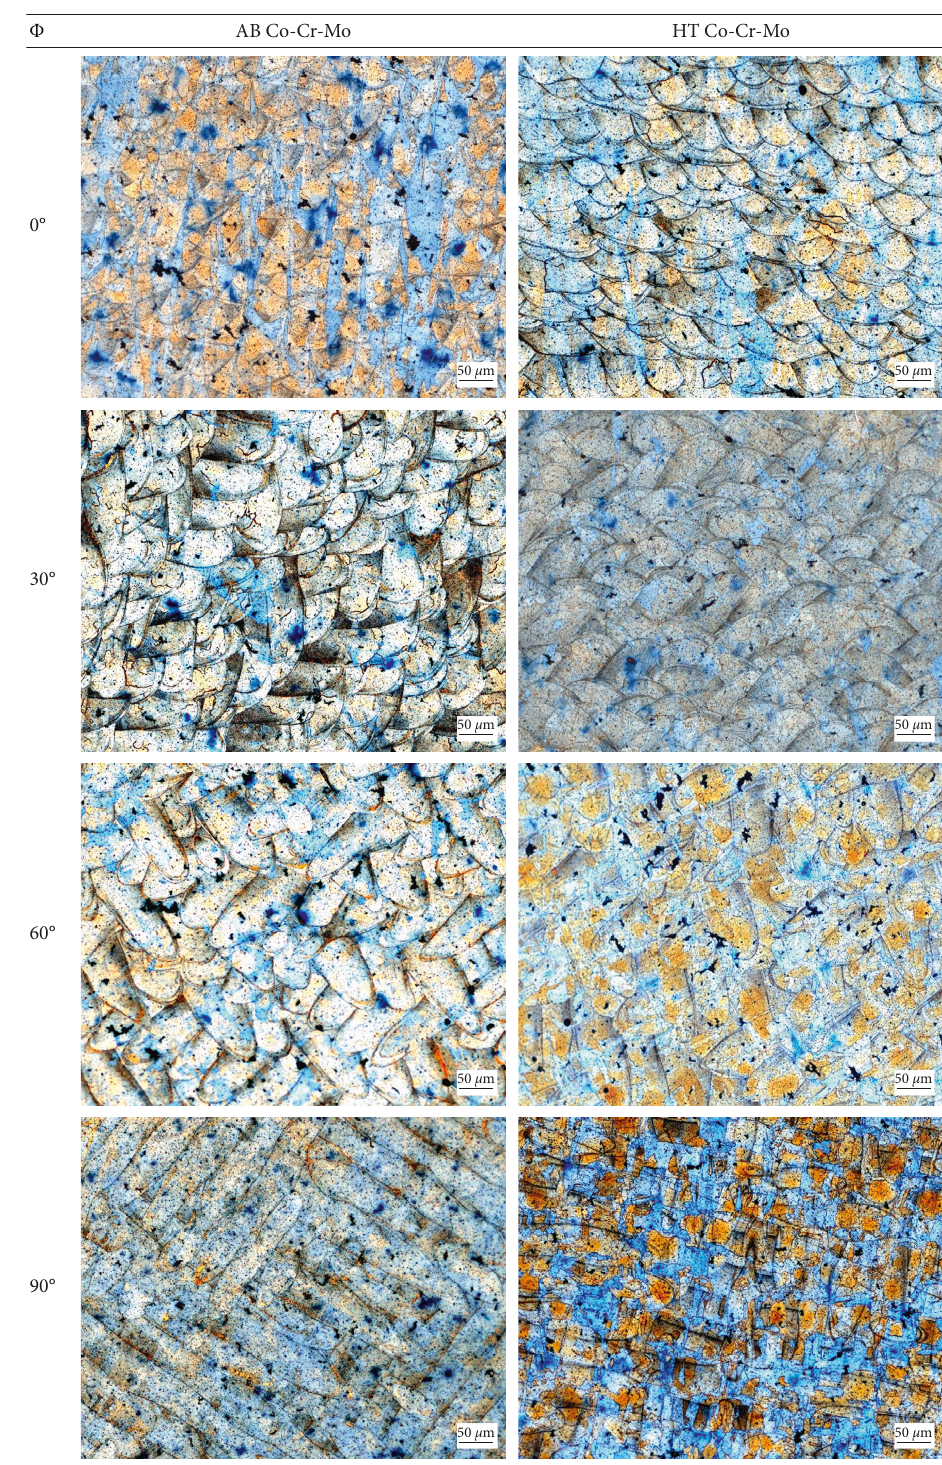
Figure 4: Microstructure (50 µ m) of AB and HT Co-Cr-Mo